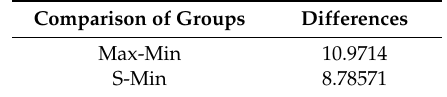
Table 5. Significant results to 95% of the multiple range test (LSD) for %S according to